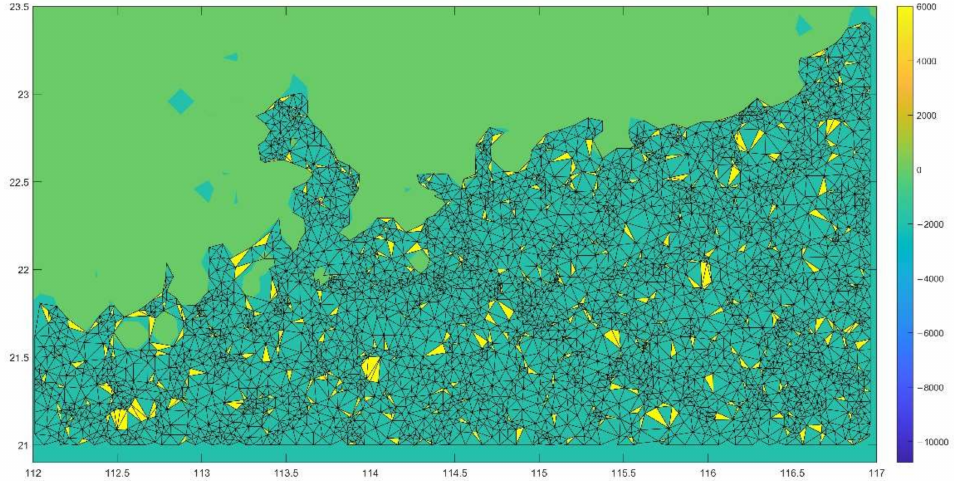
Figure 16. Comparison before and after the generation and optimization of the unstructured grid of the inlet range of the South China